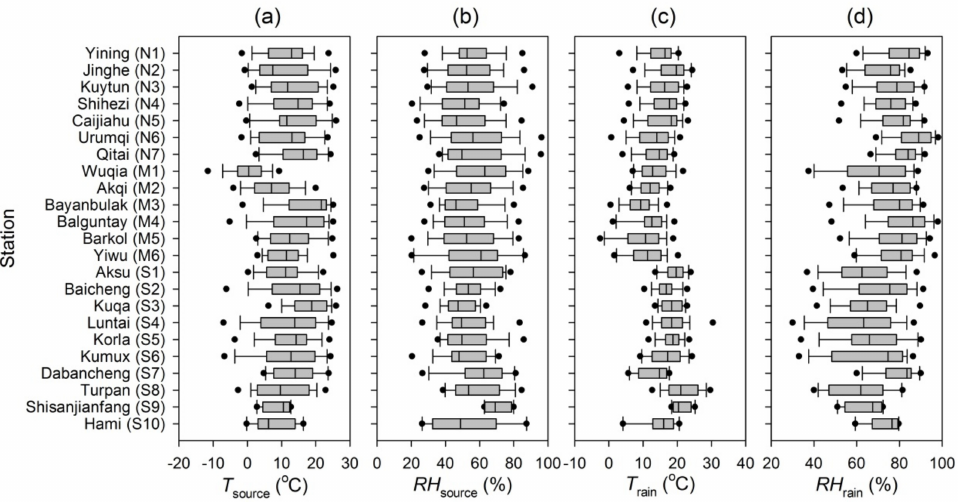
Figure 8. Air temperature ( T ) and relative humidity ( RH ) at moisture sources ( a and b ) and sampling sites ( c and d ) around the Tianshan Mountains, during summer